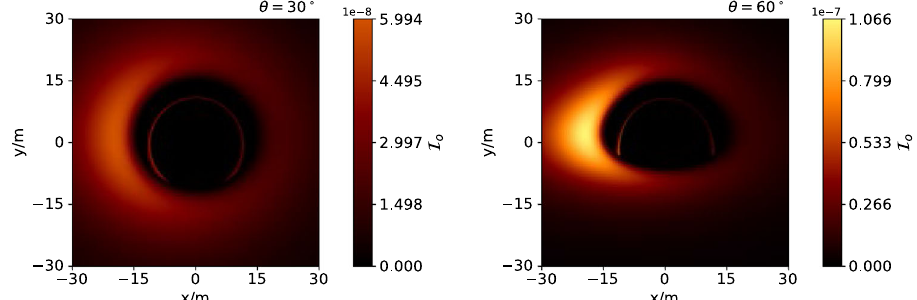
bottom row is for θ 0 = 60 ◦ . In each row, the magnetic dipole parameter b from left to right is taken to 0, 0.8 and 1.6 respectively. Here, we set m = 1